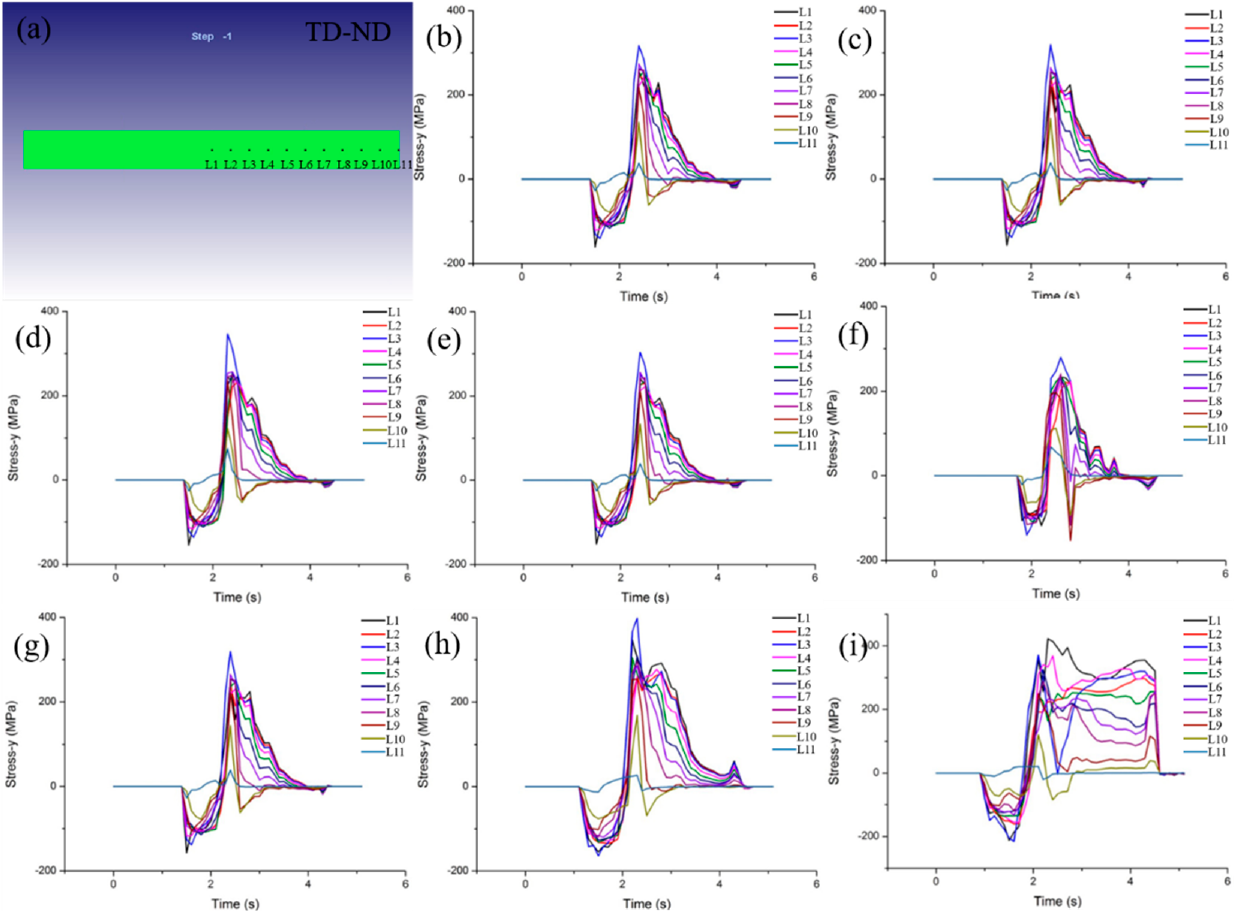
Figure 10. Distribution of characteristic points on TD − ND plane ( a ), the additive stress changes along TD at different temperatures ( b – e ) 1300–1600 °C, and different reductions ( f – i ) 10–40%. Figure 10f–i shows the tensile stress distribution of ND − TD plane at 1400 ◦ C and different rolling reduction. The reduction is 10%, and the maximum tensile stress in TD direction is 280 MPa. While the rolling reduction increases to 20% and 30%, the maximum tensile stress is 319 and 399 MPa, respectively. Similar to Figure 10b–e, the maximum tensile stress along the TD direction also appears at L3. This indicates that the stress thresholds for longitudinal crack formation are 280, 319 and 399 MPa, corresponding to 10%, 20% and 30% of the reduction, respectively. However, when the reduction is 40%, the tensile stress curve shows two peaks. The first peak was at L3 with a tensile stress of 371 MPa, and the second peak was at L1, with a tensile stress of 423 MPa. As the reduction increases, the tensile stress along the TD direction obviously increases, and longitudinal cracking is more likely to occur. Moreover, when the reduction reaches 40%, the longitudinal cracking of the rolled tungsten plate changes from one crack type to two crack types. Thus, in order to avoid the formation of longitudinal cracks, low temperature and low pressure rolling are selected as far as possible within the set rolling temperature (1300–1600 ◦ C) and the amount of pressure (10–40%). Due to different parts of the constraints, uneven deformation occurs in the wide part of the rolling tungsten plat, resulting in the formation of additional tensile stress on the RD-ND plane. This can cause side crack formation. Figure 11 shows the stress distribution along the RD direction of nine selected feature points on the RD − ND plane at 1400 ◦ C